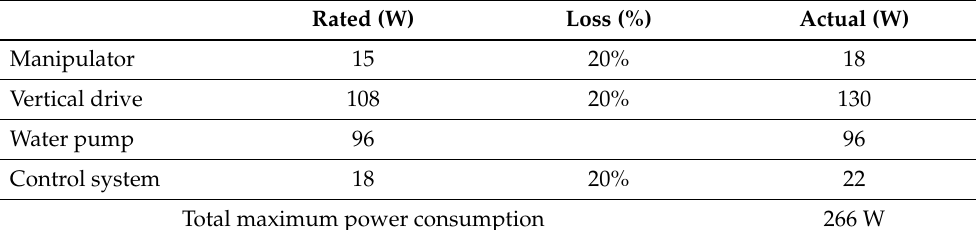
Table 1. Estimated power use of the system. Rated (W) Actual